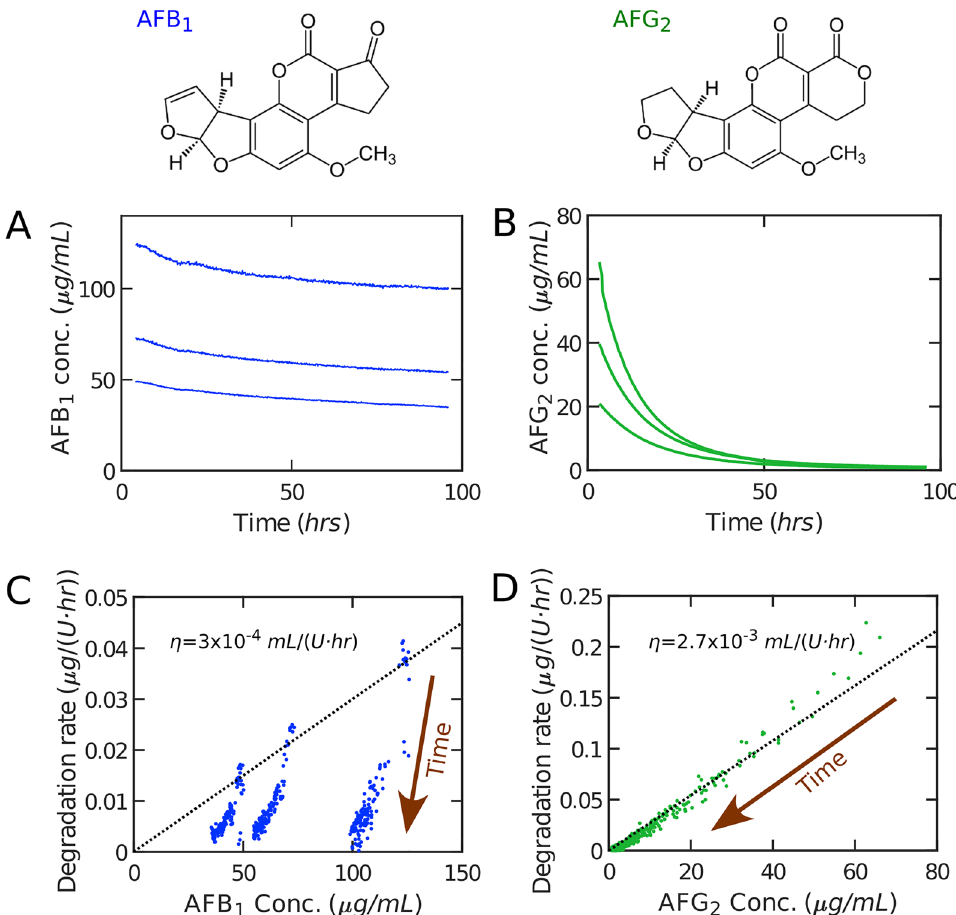
Figure 1. The detoxification of AFB 1 and AFG 2 by laccase highlights the difference in detoxification efficiencies even between aflatoxins with similar structure. Different initial aflatoxin concentrations were employed and are represented for AFB 1 ( A ) and AFG 2 ( B ). Each curve is the average of 3 replicates. A subset of points from ( A,B ) is randomly selected and represented in ( C,D ) to calculate the local normalized detoxification rates (cid:31) − 1 [ L ] Here, [ T ] is the toxin concentration and [ L ] is the laccase concentration. Detoxification efficiency def = − 1 � [ T ] (cid:31) η [ L ][ T ] � t (cid:30) of AFB 1 ( C ) is almost an order of magnitude lower than that of and AFG 2 ( D ) at comparable concentrations. Dotted lines in ( C,D ) illustrate the prediction of the model. Direction of time is represented in ( C,D ) to highlight the decrease in toxin concentration as a result of detoxification. Laccase concentration: 25 U/